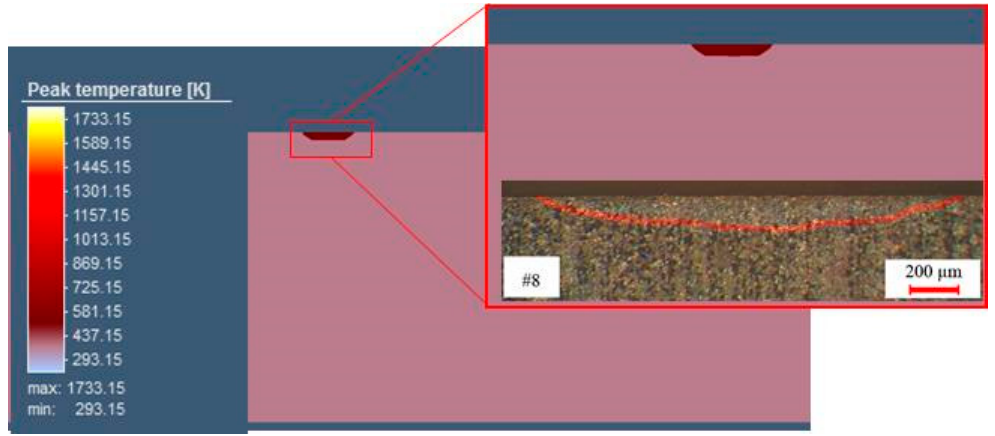
Figure 16. Cross section of sample #8 and calibration of the model.